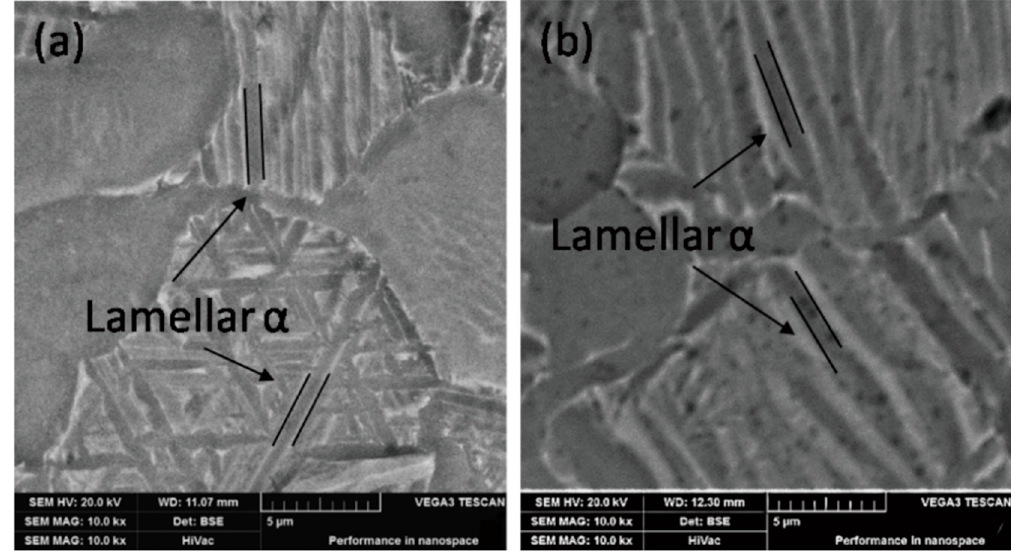
Figure 12. BSE image of microstructure under the different solution treatments followed by aging ( a ) 960 ◦ C × 1 h, AC + 600 ◦ C × 2 h, AC; ( b ) 960 ◦ C × 1 h, AC + 750 ◦ C × 2 h,